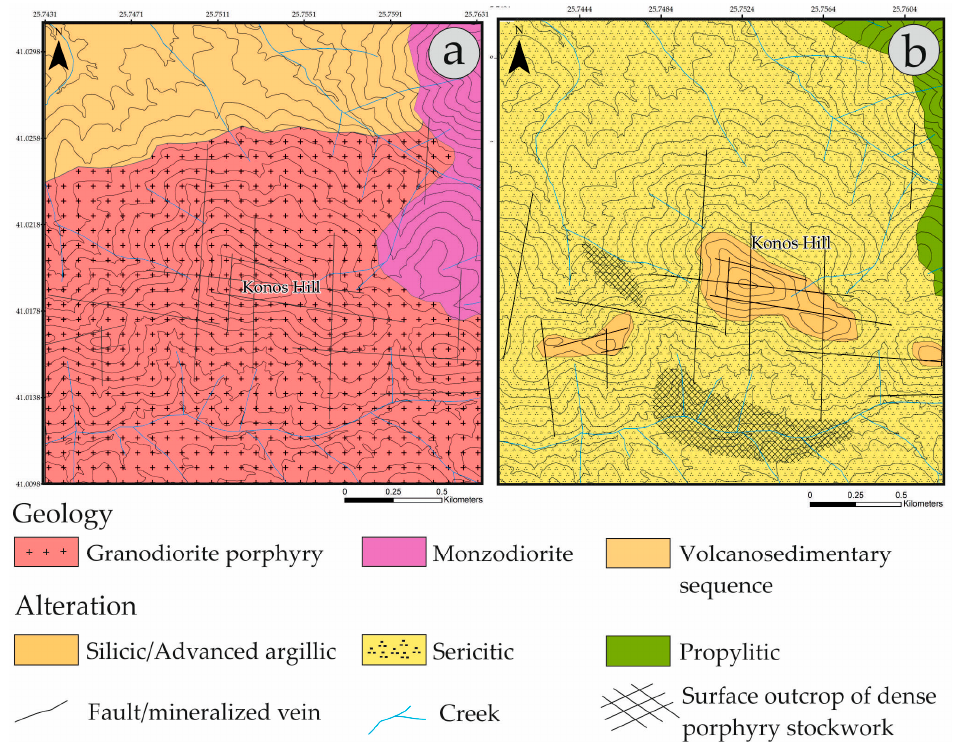
Figure 2. Geological ( a ) and alteration ( b ) map of the Konos Hill area, NE Greece (modified after Mavrogonatos et al., [35]).